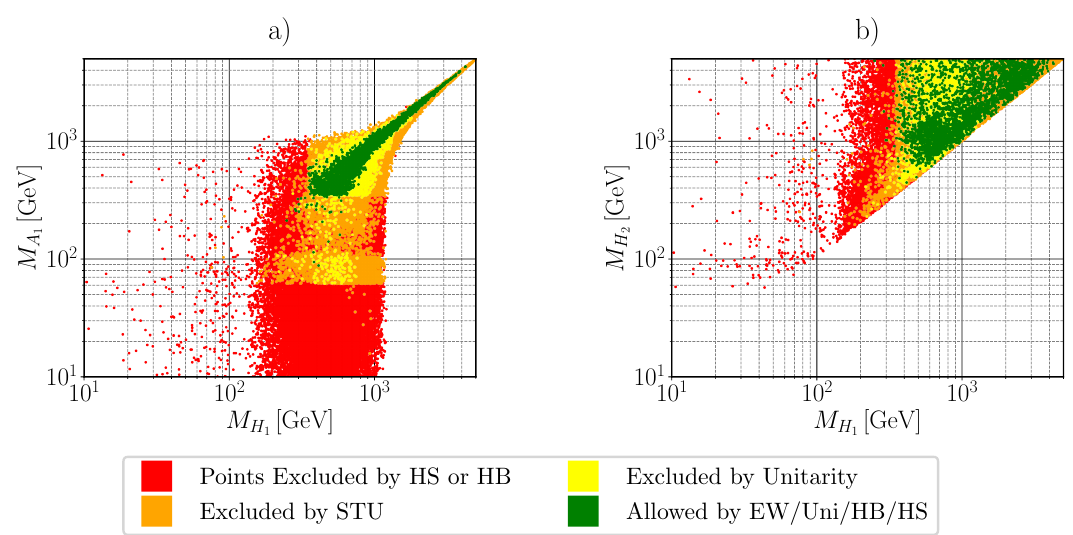
Figure 2 . Scatter plots of the allowed parameter space under several constraints imposed by the BGL-like 3HDM. While on the right panel, b), we plot the masses of the two lightest BSM CP-even scalars H and H , the left one, a), showcases the relation between H 1 2 counterpart H . 2